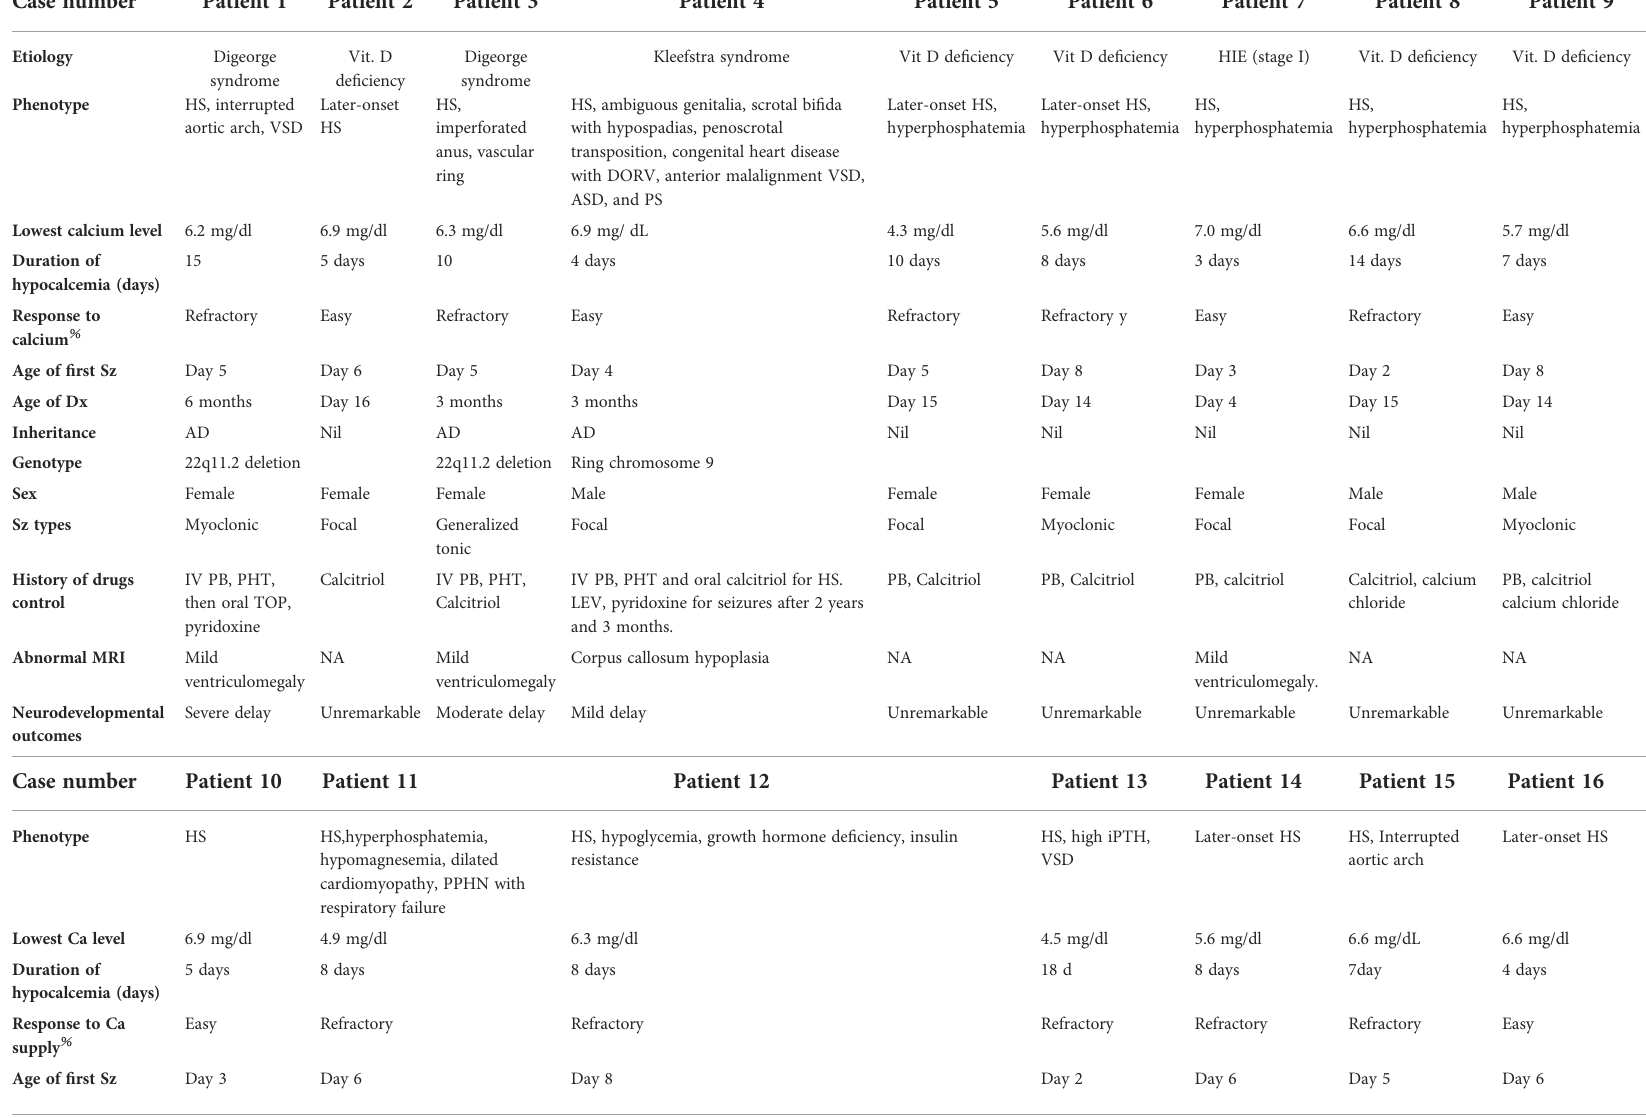
TABLE 1 Clinical presentations and etiologies of hypocalcemic seizures in 16